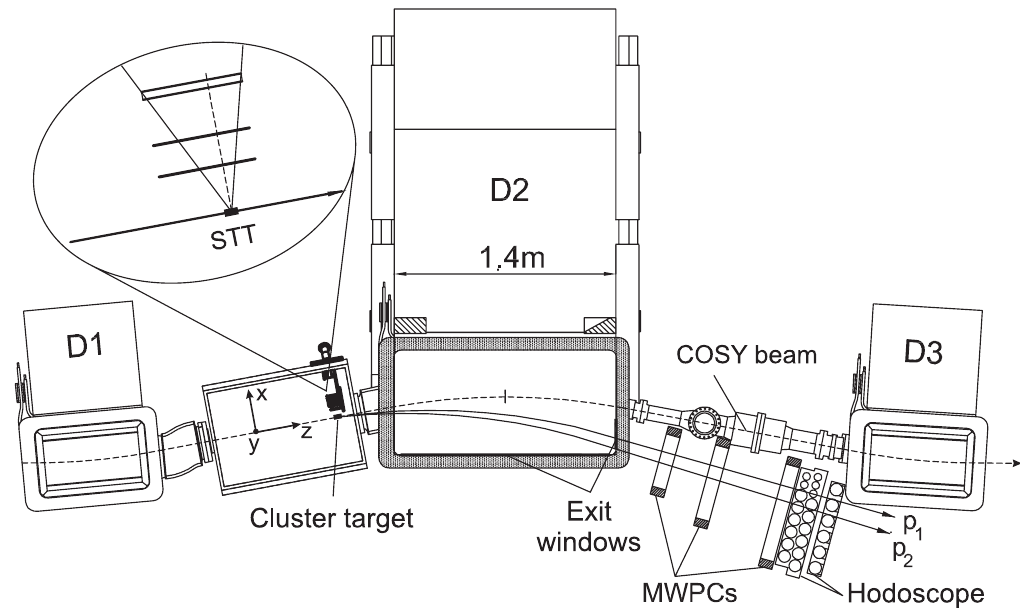
FIG. 3. The ANKE experimental setup, comprising the three dipole magnets D1, D2, and D3. Inside the target chamber, a silicon tracking telescope (STT, shown in the inset and separately in Fig. 4) is mounted near the target jet, with the hydrogen clusters proceeding parallel to the (cid:6) y direction. The forward detector (FD) comprises three MWPCs and a hodoscope composed of three layers of scintillation counters.